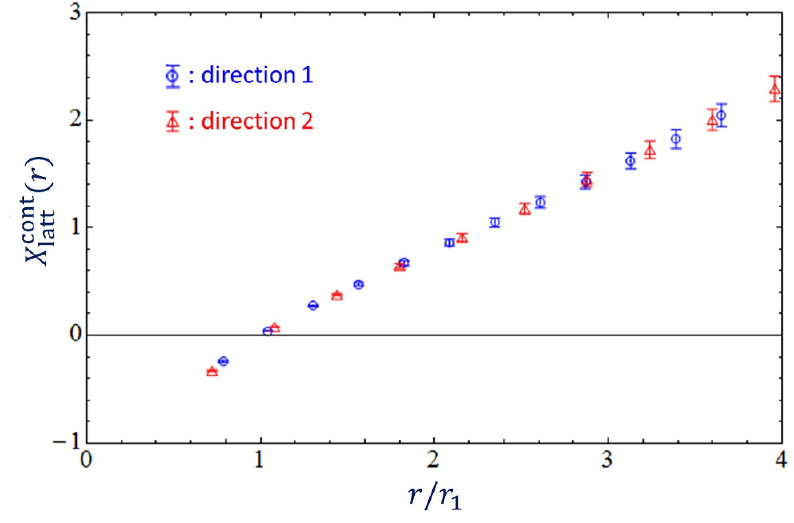
. Blue points originate from d = 1 and red latt